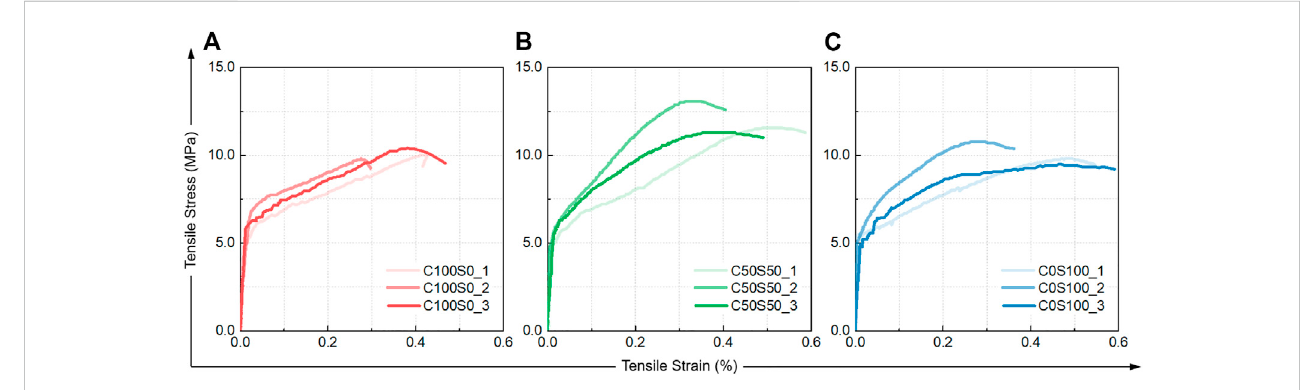
FIGURE 8 Tensile stress – strain curves of SH-UHPGC (A) C100S0, (B) C50S50, and (C) C0S100.